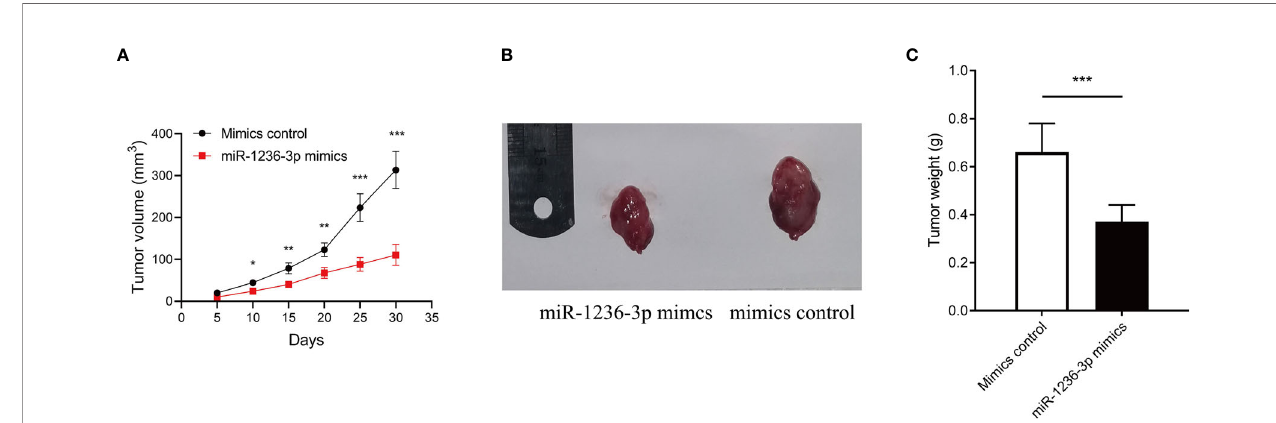
FIGURE 4 | MiR-1236-3p inhibited colon cancer growth in vivo . Nude mice were subcutaneously injected with SW620 cells stably transfected with miR-1236-3p mimic or control. (A) Changes in tumor volume, (B) representative xenografts, and (C) tumor weight were evaluated in nude mice. Error bars represent the mean ± s.e.m.; *P < 0.05, **P < 0.01, ***P < 0.001 by Student ’ s t-test, six replicates per group for